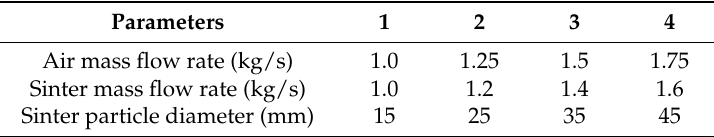
Figure 4. The temperature distributions of air and sinter along the height of the sinter bed layer. Table 3. Parameters of different